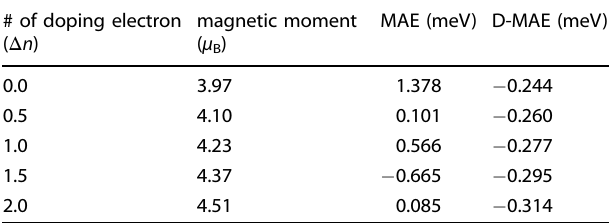
Table 1. Magnetic moment and anisotropy energies for each number of doping electrons per atom.